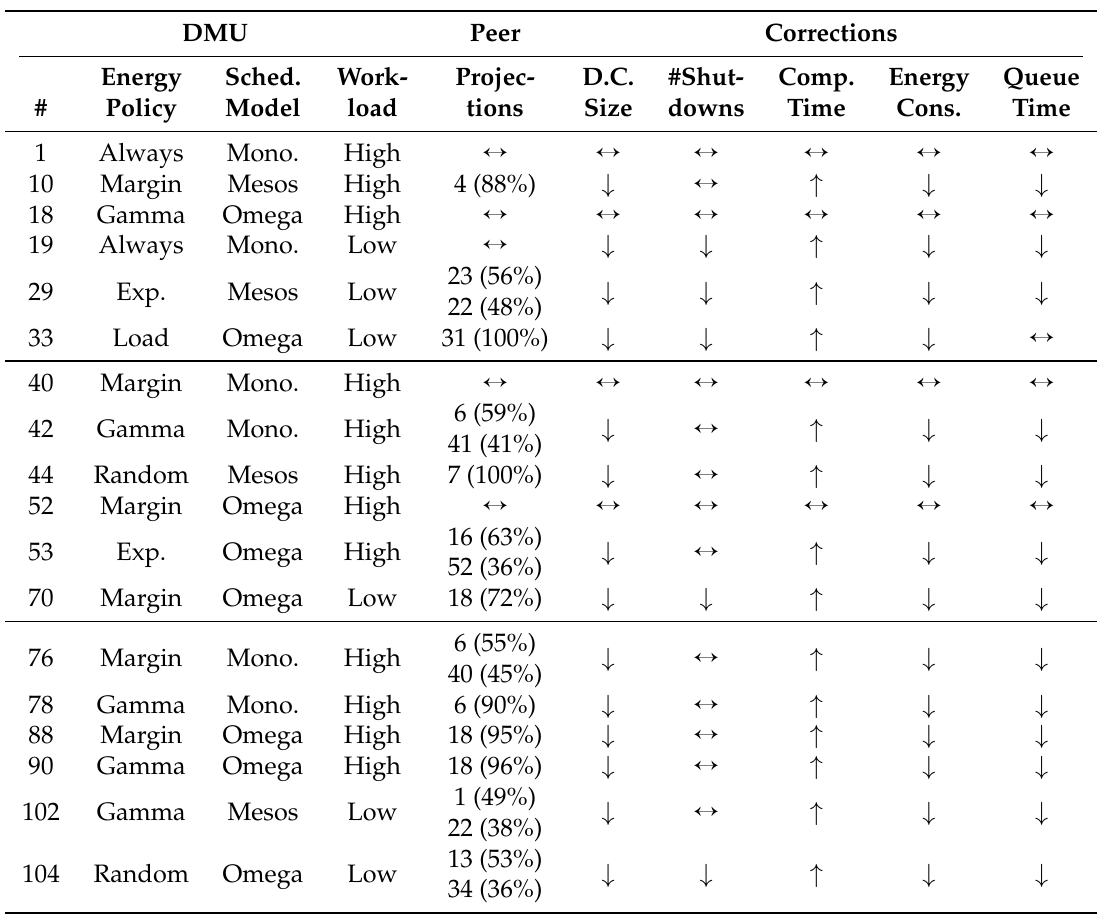
Table 5. Resulting proposed corrections following DEA analysis. Peer projections for a DMU indicate which DMU it should emulate. The following actions may be taken for each input and output: ↑ when the parameter must be increased; ↓ if the parameter must be reduced; and (cid:214) if no further actions are needed to achieve